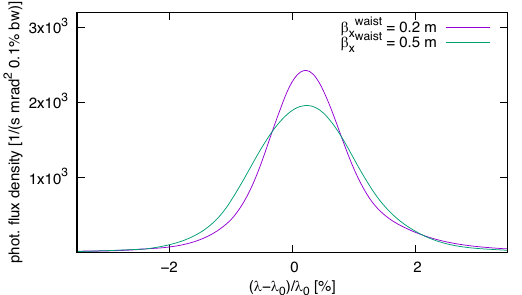
FIG. 12. Incoherently added radiation spectra emitted by particle bunches with E ¼ 120 MeV, ϵ x ¼ 10 − 8 m rad for two different choices of β waist x , observed at 10 5 m